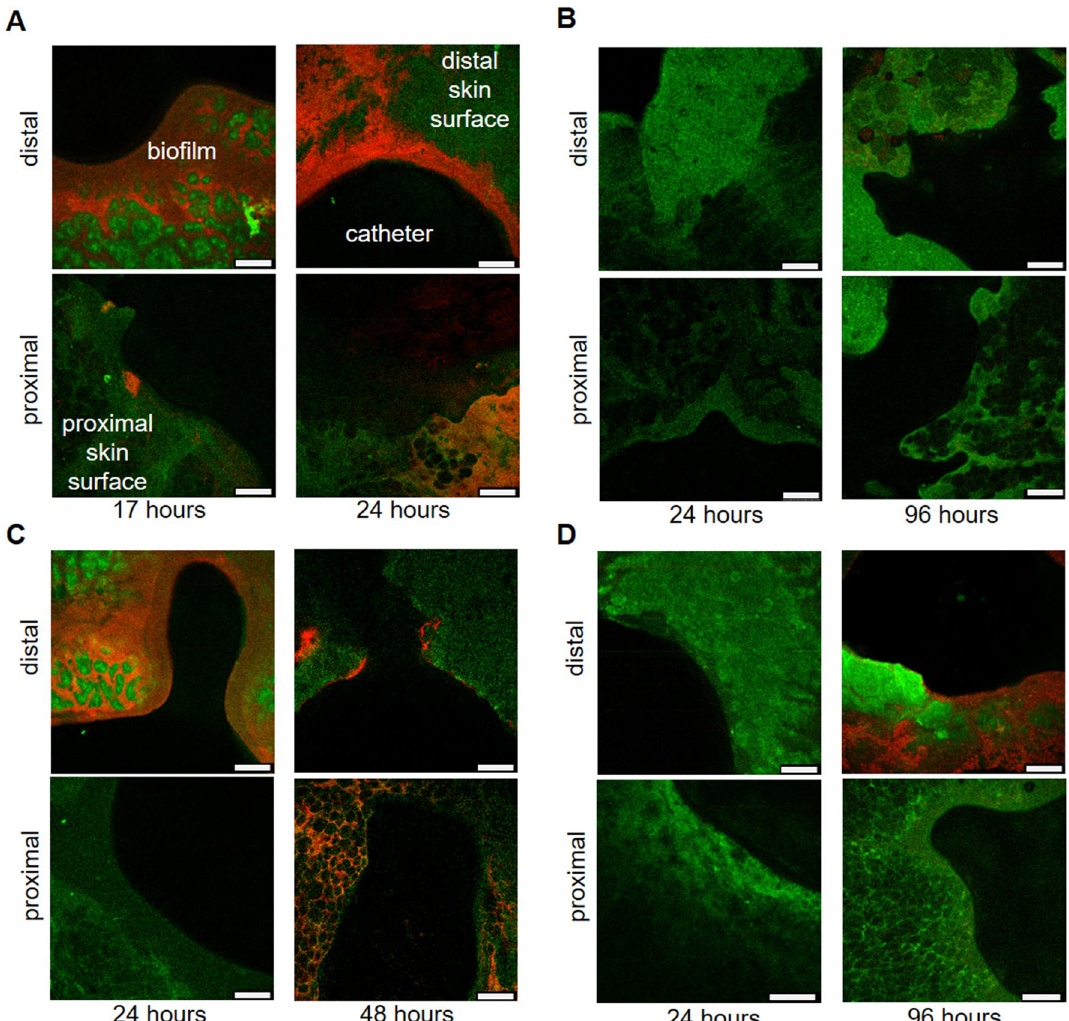
Figure 5. Fluorescence confocal laser scanning microscopy images of porcine skin’s distal and proximal surfaces that had been in contact with different catheters. Skin surface autofluorescence is green, RP437/ pRSH103 E. coli is red, and the black region is insertion site of catheter. Images for each timepoint were taken of sections around the catheter, as seen by the curvature where the biopsy punch was made. Distal side is the epidermis and proximal side is mostly hypodermis and associated fat cells. ( A ) Skin around unmodified catheter, ( B ) Skin from antibiotic control, ( C ) Skin around non-eluting catheter, ( D ) Skin around eluting catheter. Scale bar = 50